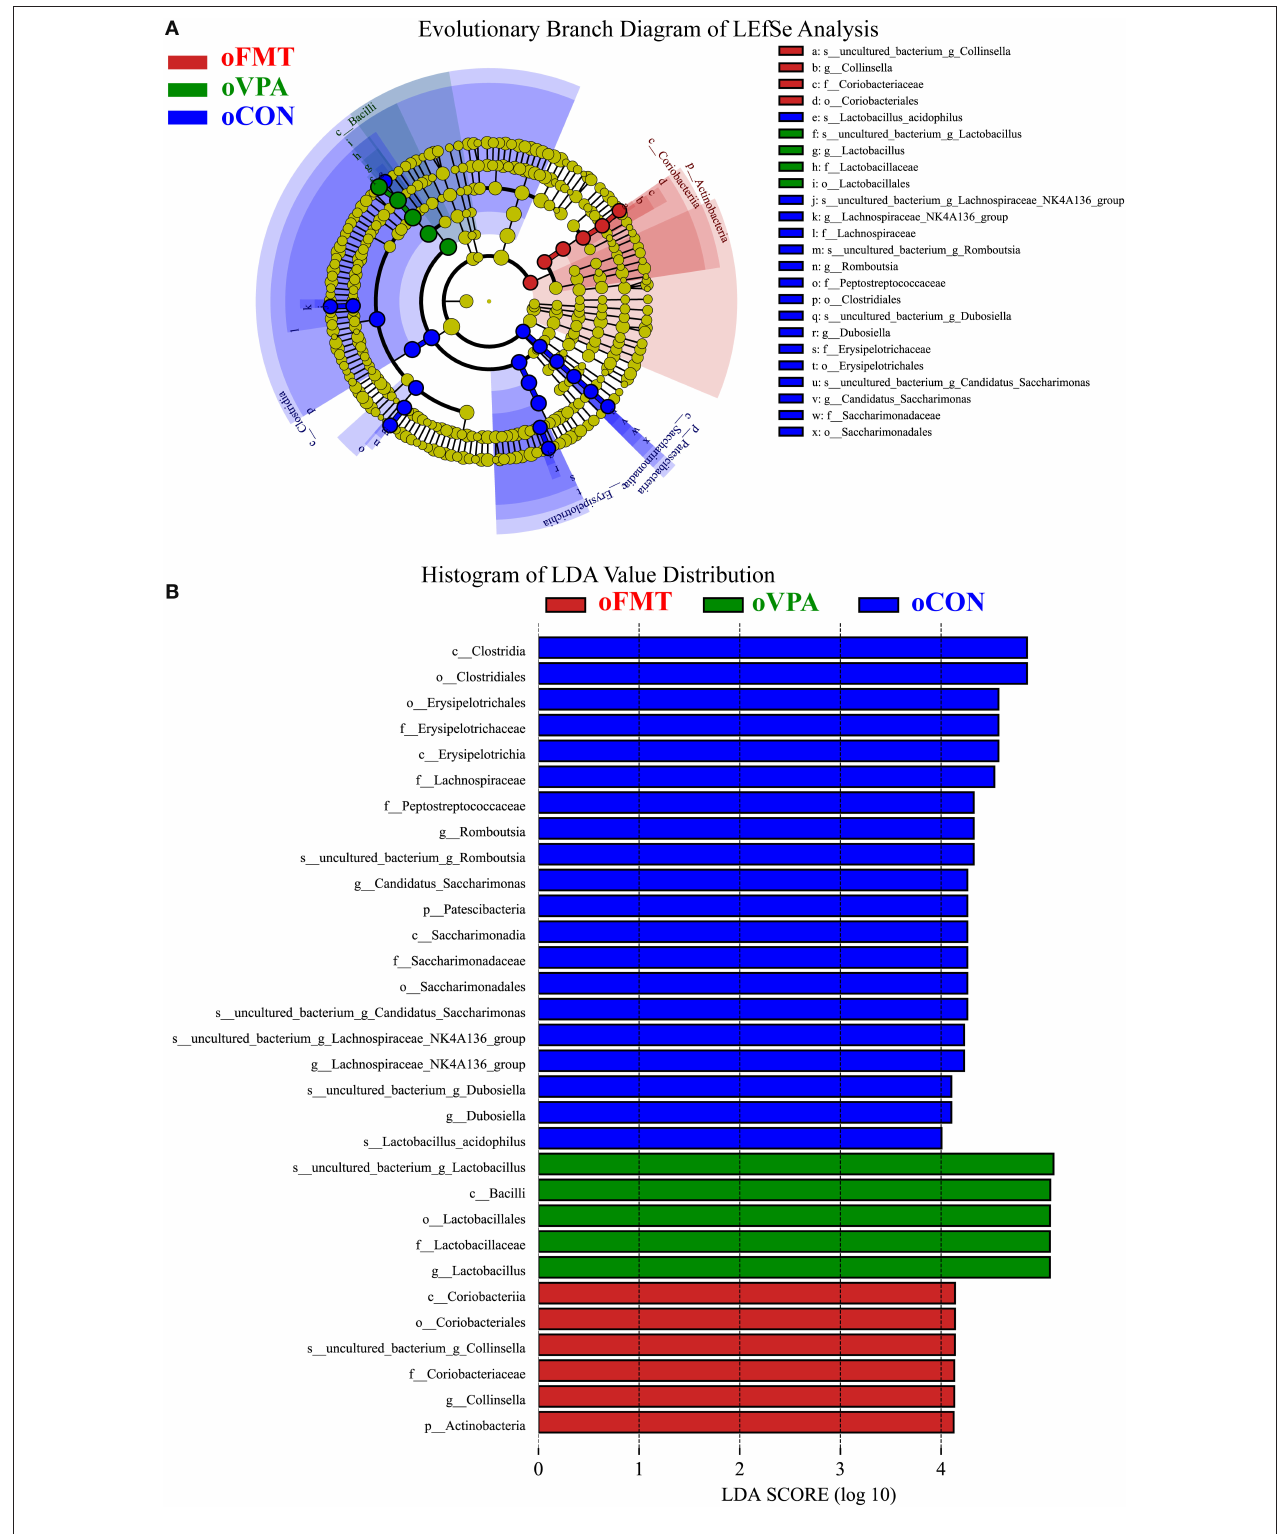
FIGURE 5 | (A) Evolutionary Branch Diagram of LEfSe Analysis. (B) Histogram of LDA Value Distribution. Linear Discriminant Analysis (LDA) Effect Size (LEfSe) analysis of gut microbiota in offspring rats among oCON, oFMT, and oVPA according to the 16S rRNA data. The yellow nodes represent the microbiota that did not play an essential role in different groups, and no biomarker meeting the requirements. The histogram of LDA value distribution and the evolutionary branch diagram of LEfSe analysis show the species whose LDA Score is higher than the set value (LDA score > 4.0, P < 0.05). The histogram’s length represents the impact size of different species (LDA Score), and different colors represent the species in different groups (red: oFMT; green: oVPA; blue: oCON).